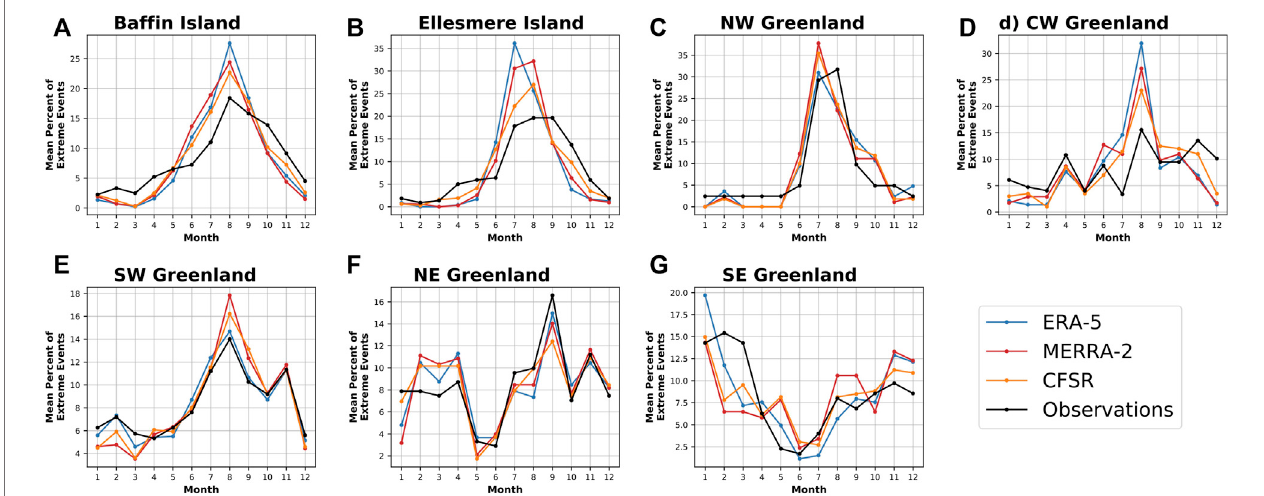
FIGURE 3 | Percent of all extreme events in each product occurring in each month for all subregions (A – G) .